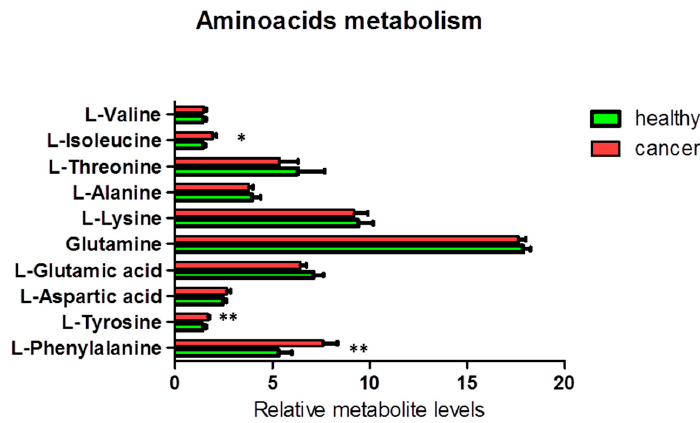
Figure 4. Percentage of metabolites (nmoles of metabolite relative to total nmoles of metabolites per g of tissue) involved in the amino acid metabolism in thyroid cancer tissue ( n = 11) and healthy thyroid tissues ( n = 10). Values are mean ± SD; (*) indicates ANOVA F values with p < 0.05, and (**) indicates q < 0.05 when FDR correction is applied for multiple comparisons.